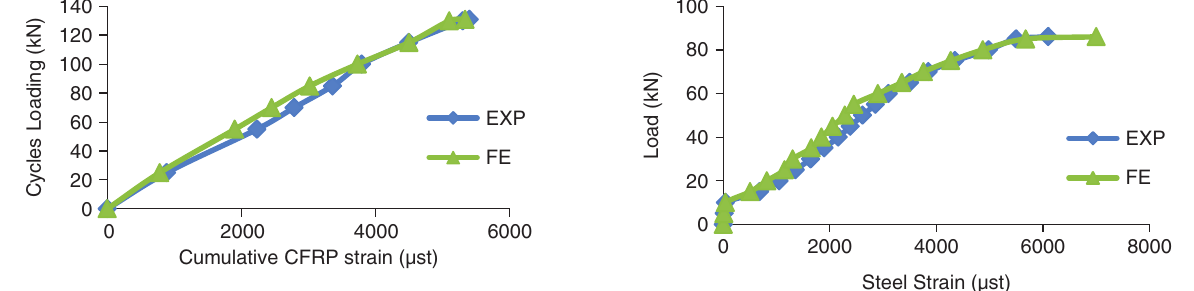
Fig. 20. Load against the cumulative CFRP strain for the post- repair phase of the beam G3R2